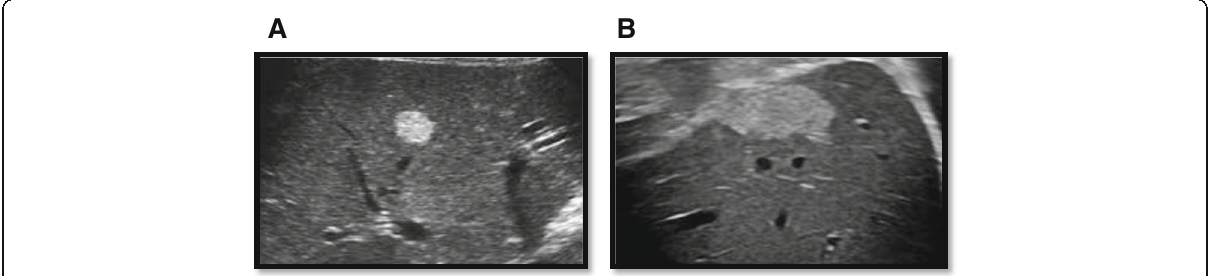
Fig. 1 Hemangioma as seen by ultrasonography. a Right lobe segment V well-defined hyper-echoic lesion close to hepatic vein. b Left lobe sub- capsular segment II hyperechoic